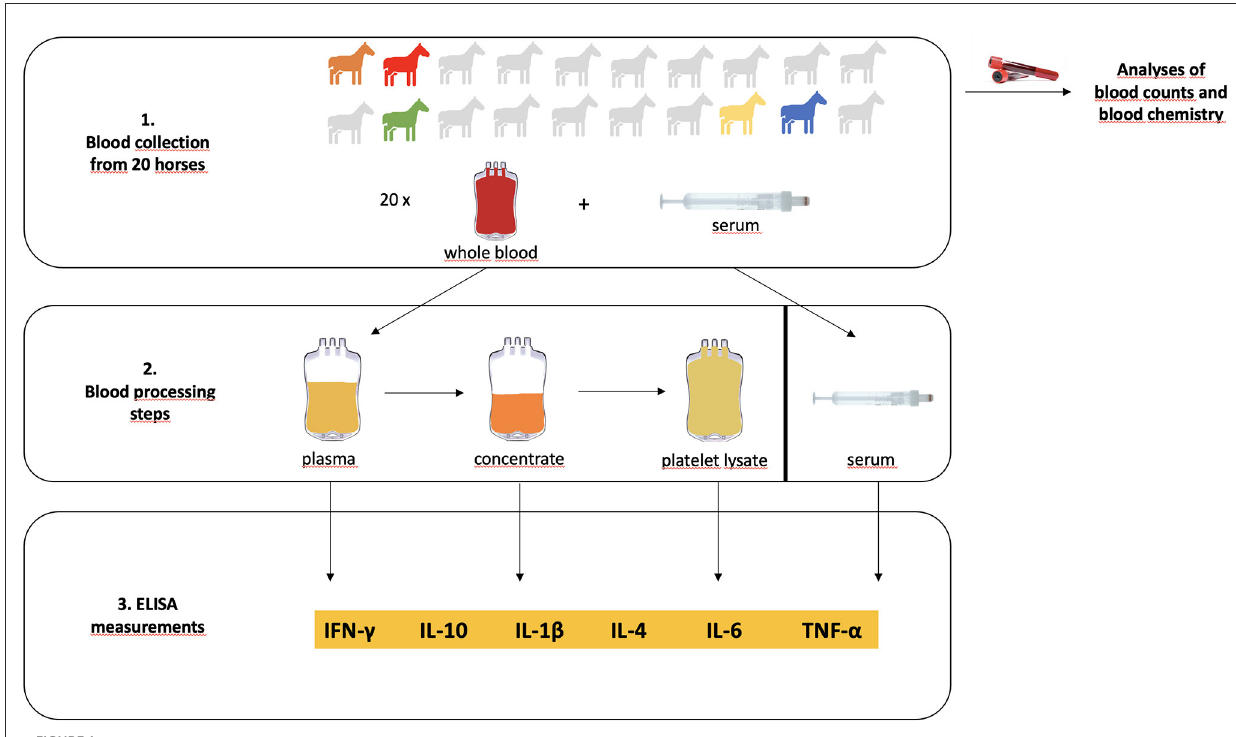
FIGURE1 Overview of the study design. Blood was collected from 20 clinically healthy horses, of which 5 turned out to have mildly to moderately abnormal findings in blood chemistry (designated by the colored icons). Whole blood was processed to platelet lysate. Serum, plasma, concentrate and platelet lysate were then subjected to ELISA measurements of their cytokine